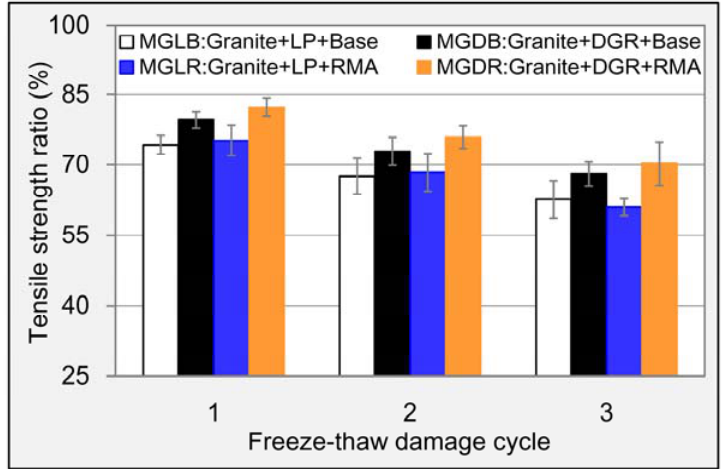
Figure 14. TSR results of different asphalt mixtures.